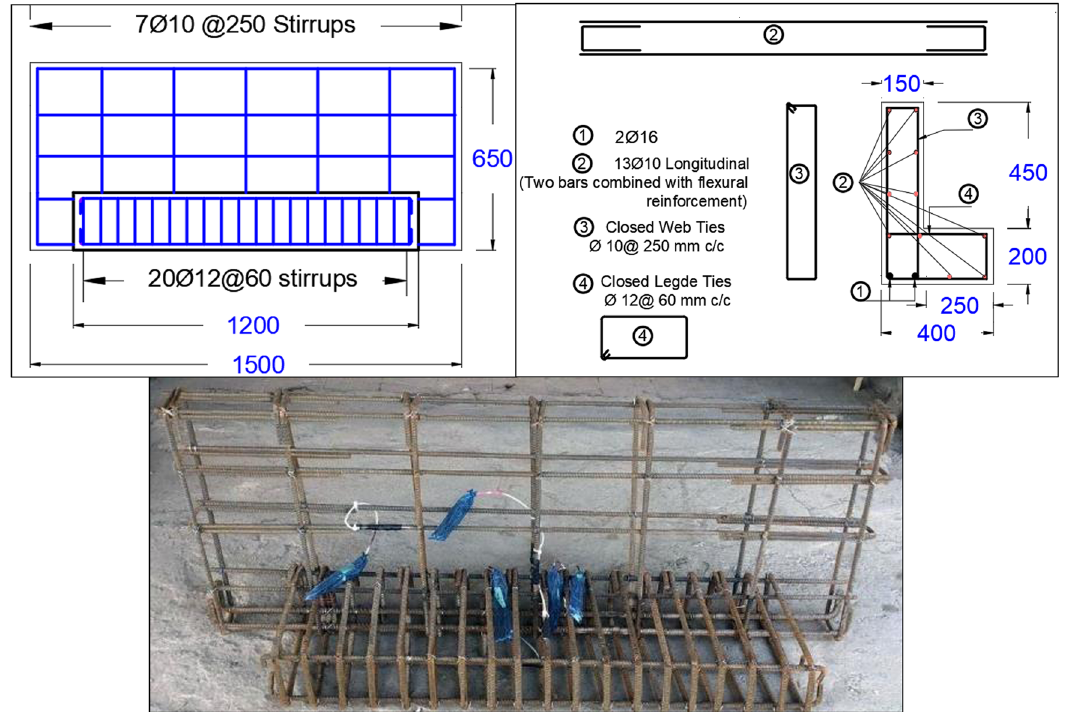
Figure 3: Reinforcement details for tested spandrels of group I ( all dimensions are in mm )